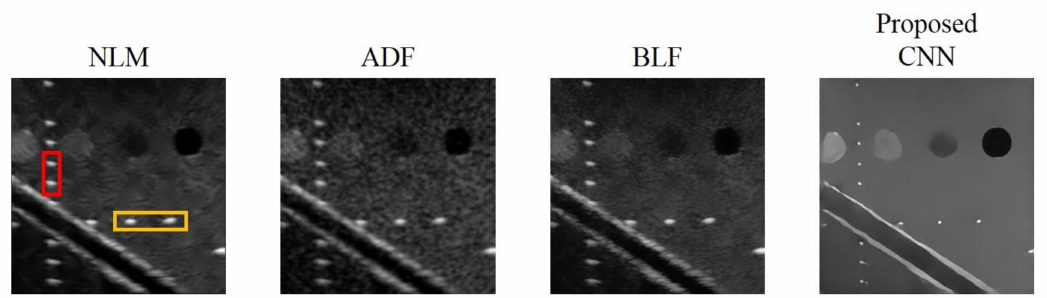
Figure 9. Reconstructed echogenicity maps of the four de-speckling techniques.